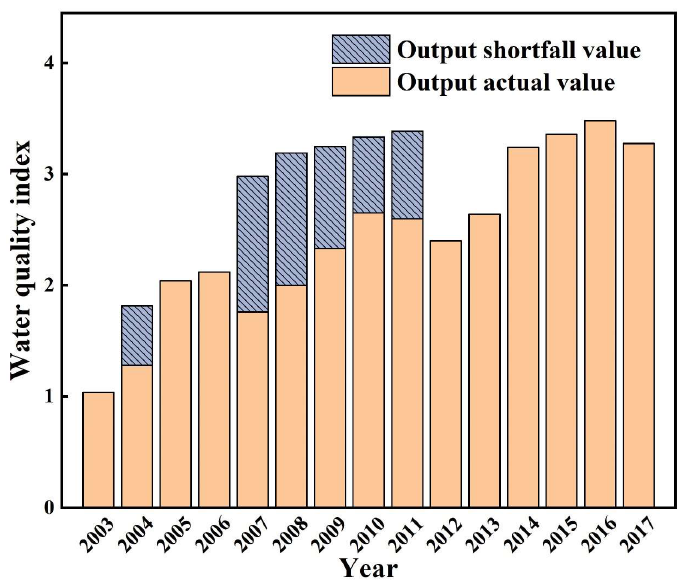
Figure 6. Shortfall and actual value of output of water pollution control from 2003 to 2017.